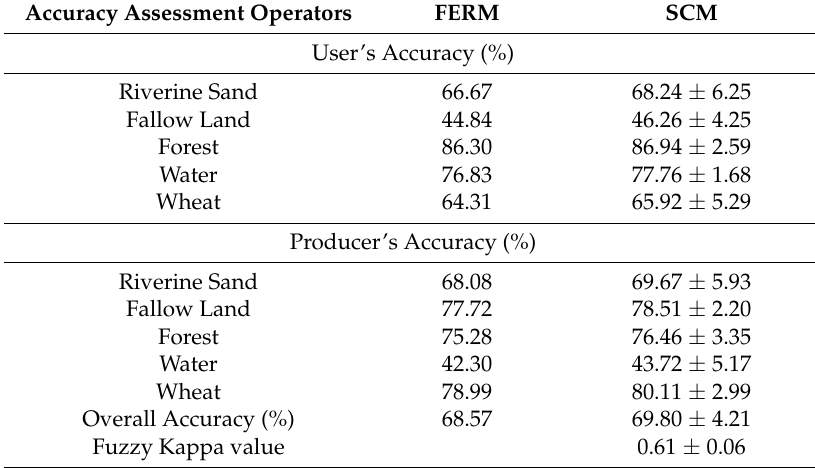
Table 9. Details of accuracy assessment for classification results of Landsat-8 data using composite